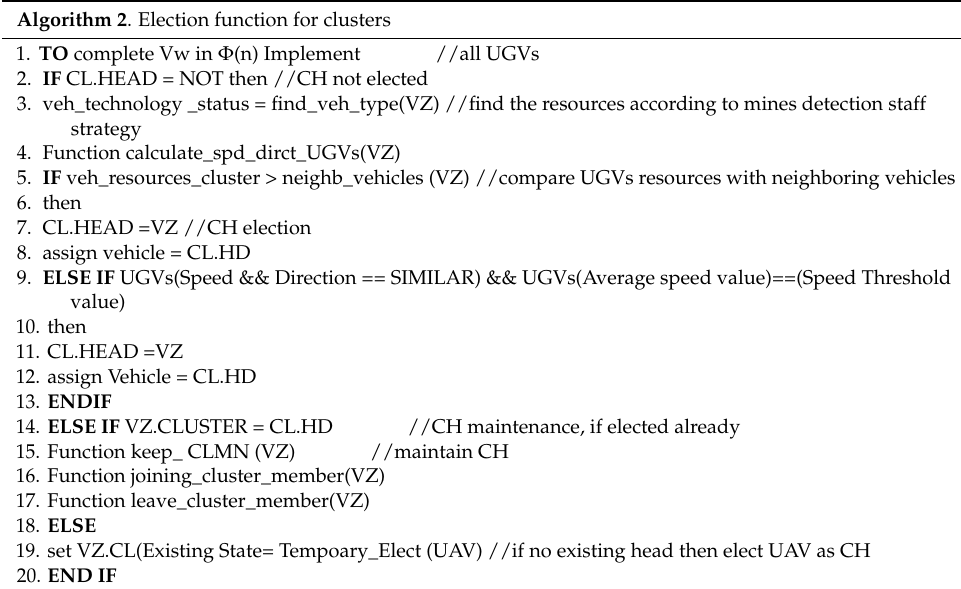
Algorithm 2 . Election function for